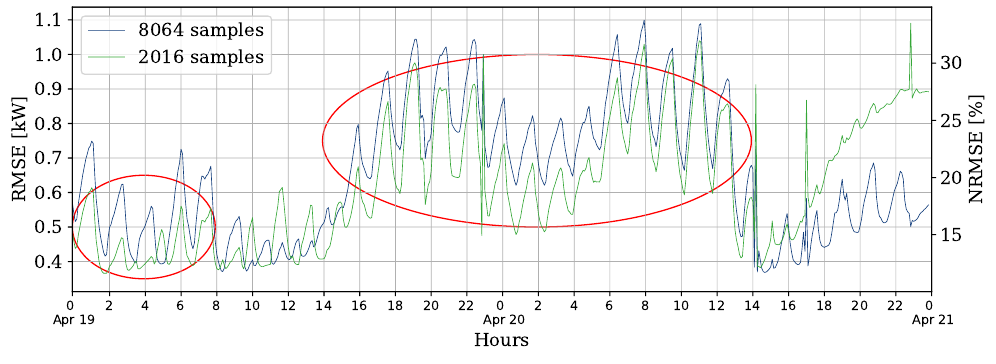
( c ) RMSE for the thermal model using fixed window sizes Figure 7. Identification of possible concept drifts in a spring